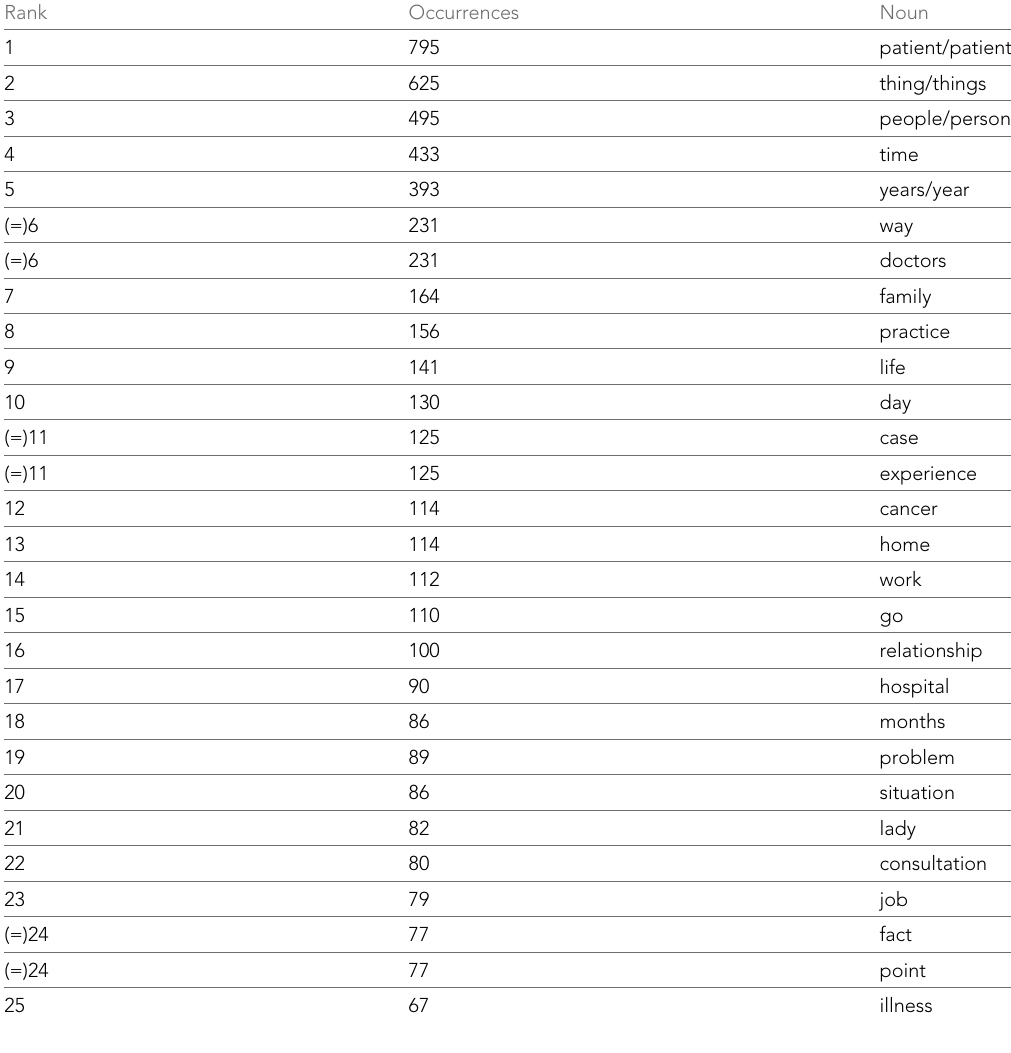
Table 1. Common nouns in all